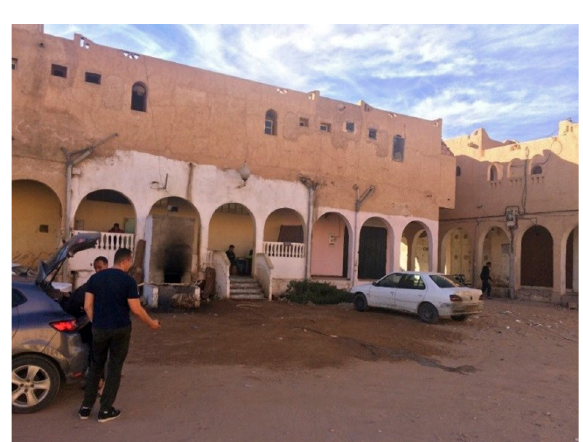
Fig. 8. Metlili’s August 20 place taken in the